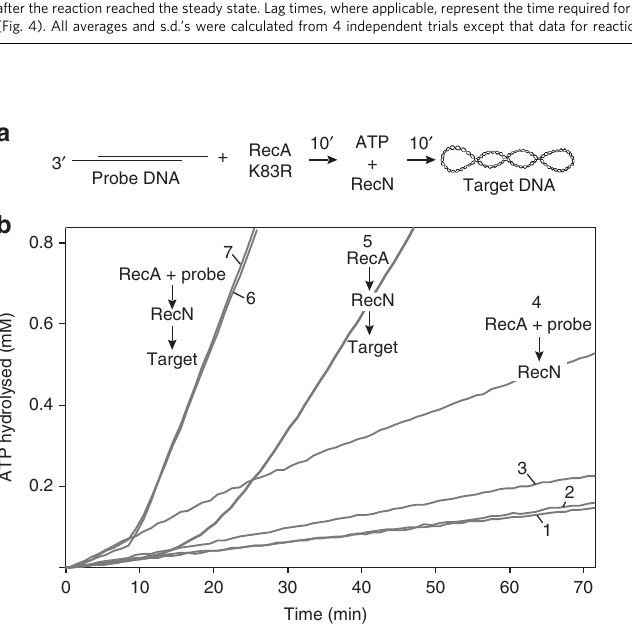
Figure 5 | The stimulation of RecN ATPase by RecA protein under D-loop assay conditions is not homology-dependent. ( a ) Schematic of reaction assembly used to monitor RecN ATPase during RecA-dependent D-loop formation. RecA K83R (3.4 m M where indicated) was incubated with probe DNA (see Fig. 2 legend) for 10min before the addition of 3mM ATP and RecN (1 m M where indicated). Target DNA (see Fig. 2 legend) was added 10min later. For each reaction described, components omitted from reactions were compensated for by protein storage buffers or TE, in the case of DNA. All reactions were carried out under buffer A conditions and followed the reaction scheme shown. ATP hydrolysis was measured after the addition of ATP. ( b ) Controls measuring RecN ATP hydrolysis in the absence of RecA K83R are shown with 10 m M probe DNA and no target DNA (reaction 1), no probe DNA and 10 m M target DNA (reaction 2), and 10 m M probe DNA plus 10 m M target DNA (reaction 3). Reaction 4: RecN ATP hydrolysis when RecA K83R protein was incubated with 10 m M probe DNA in the absence of added target DNA. Reaction 5: RecN ATP hydrolysis when RecA K83R protein was incubated in the absence of probe DNA followed by 10 m M target DNA. Reaction 6: RecN ATP hydrolysis when RecA K83R protein was incubated with 10 m M probe DNA followed by 10 m M target DNA. Reaction 7: RecN ATP hydrolysis when RecA K83R protein was incubated with 10 m M probe DNA followed by 10 m M non-homologous, supercoiled RF1 f X174 DNA. See Table 2 for steady-state RecN ATP hydrolysis